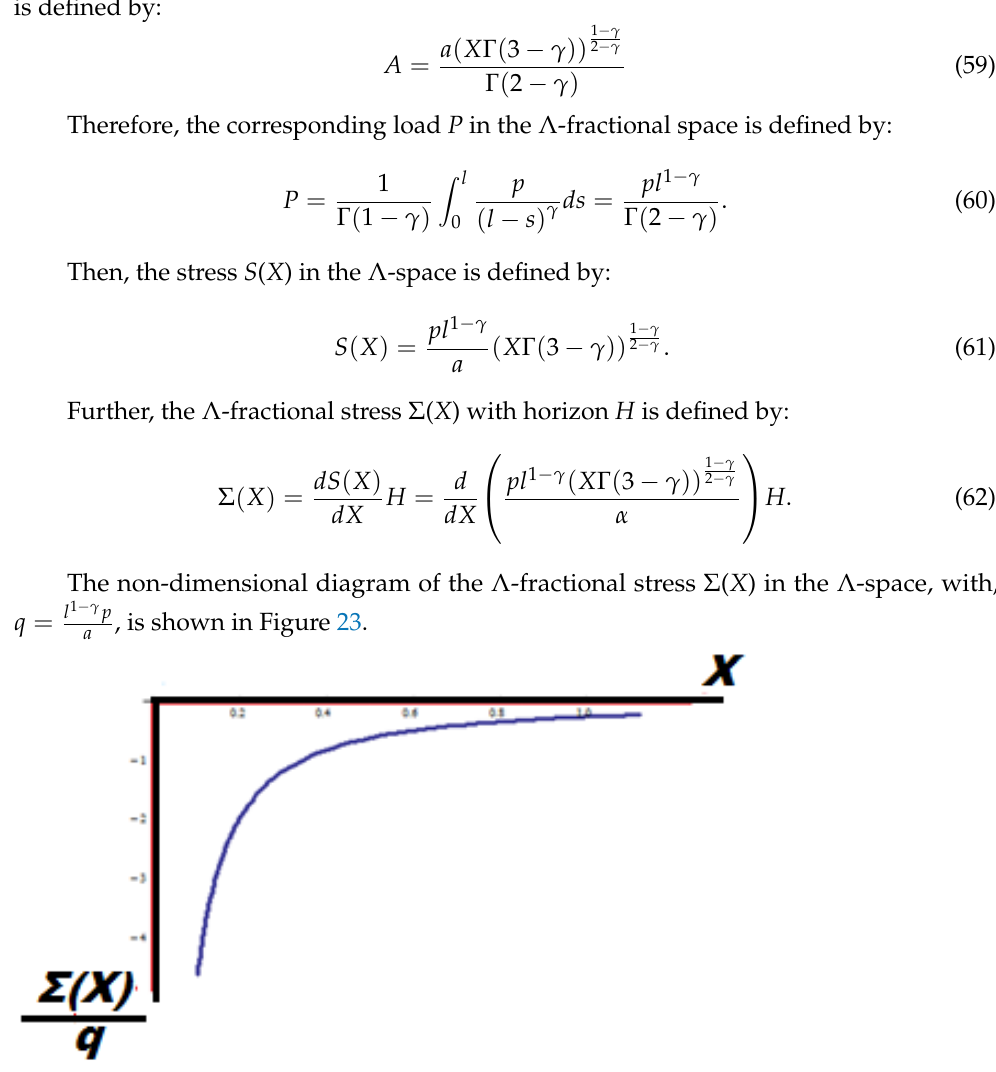
The left Λ -fractional stress in the initial space with q = l Proceeding, the average of the left and right fractional stresses is shown in Figure 25. Those stresses are the true stresses for the fractional tension of the Cantor rod in the initial